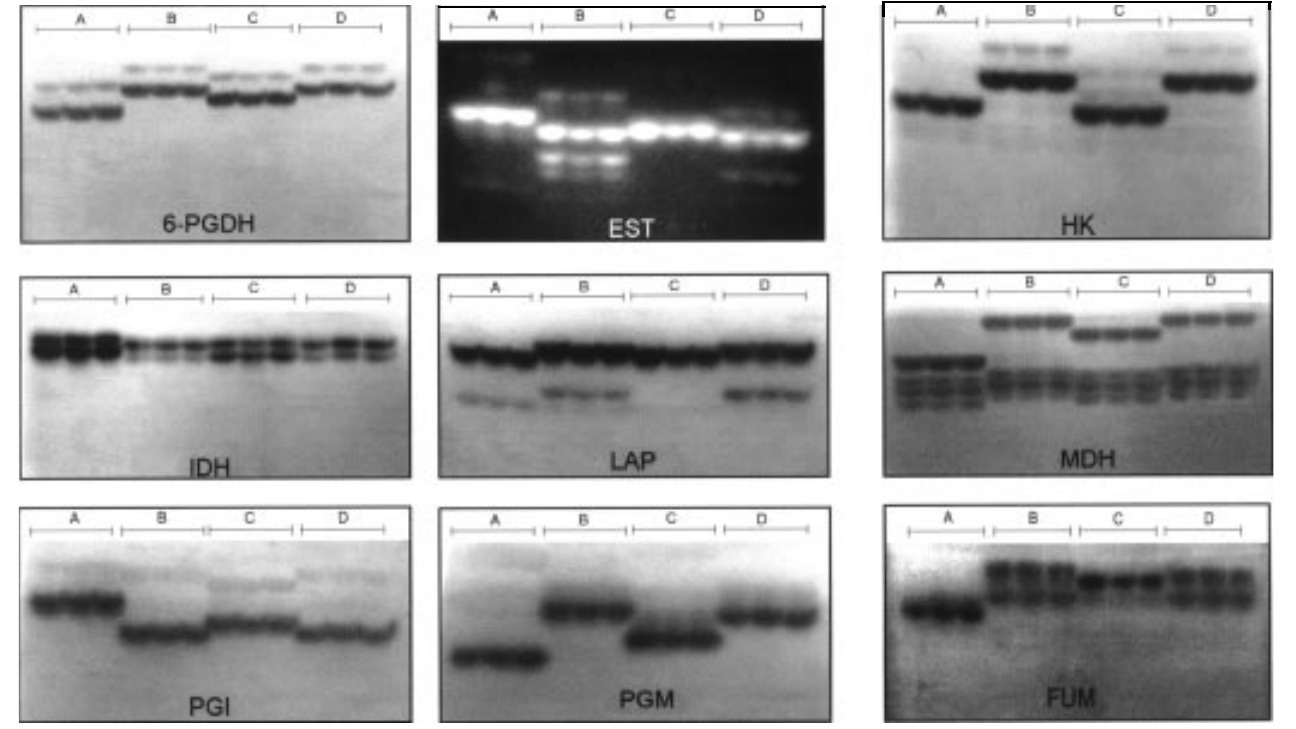
Figure 1 - Isoenzyme phenotypes of Arthrobotrys isolates. Lane A , A. musiformis ; Lane B , A. conoides ; Lane C , A. robusta ; Lane D , A. conoides . The original and two monoconidial cultures are shown from left to right for each isolate. For enzyme abbreviations, see